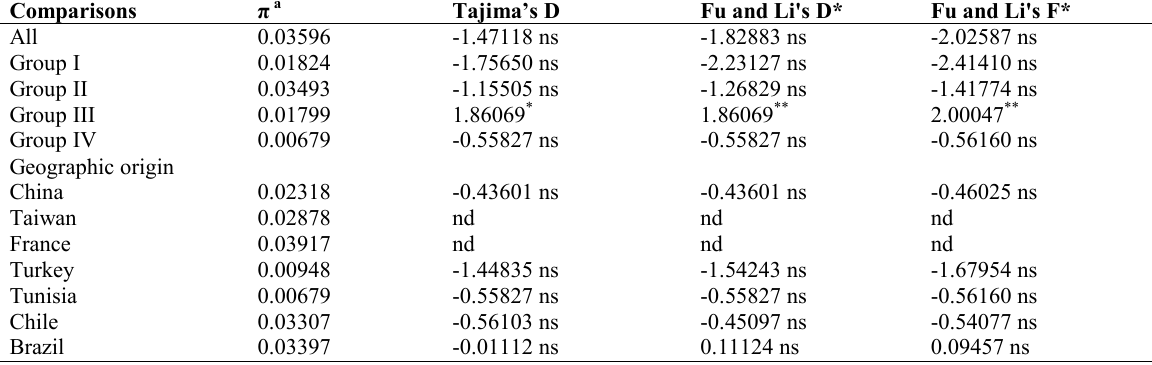
Table 3. Summary of neutrality test statistic values in LMV